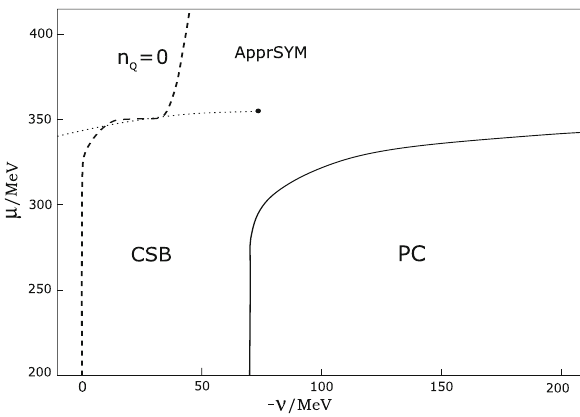
Fig. 2 The (μ,ν ≡ μ Q / 2 ) -phase diagram of dense quark matter which is in the β -equilibrium with electrons at ν 5 = 0, μ 5 = 0 and m 0 = 5 . 5 MeV. PC denotes the phase with charged pion condensation. CSB and ApprSYM denote the phases where there is no pion conden- sation and dynamical quark mass is much greater or around the current quark mass value, respectively. A solid line corresponds to second order phase transitions. A dotted line corresponds to first order phase transi- tionsbetweenCSBandApprSYM phases. Along the dashed“neutrality line” the density of electric charge (cid:6) n Q (cid:7) equals to